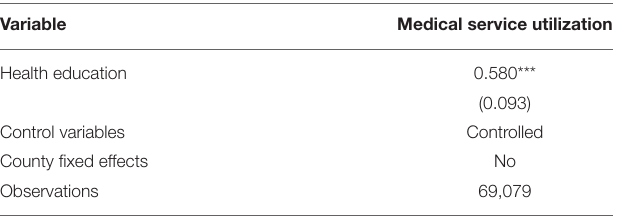
TABLE 4 | The effect of health education on medical service utilization of the migrants (IV model).